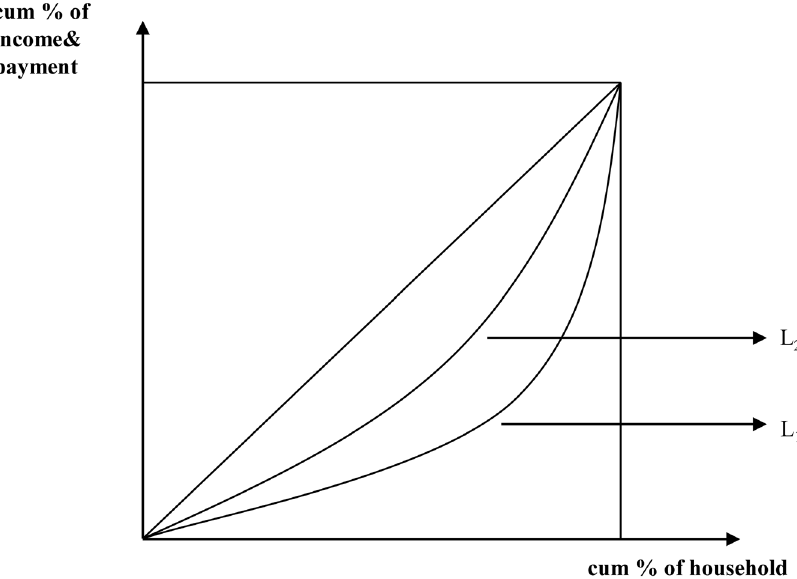
Figure 1. Conceptual cumulative concentration curve for healthcare payments and Lorenz curves. Conceptual cumulative concentration curve for healthcare payments and per capita household expenditure are shown. The concentration curve plots the cumulative percentage of healthcare payments (y-axis) against the cumulative percentage of the population (x-axis). Population is ranked according to ATP, from poorest to richest. The value of the concentration index is measured as twice the area between the concentration curve, L 1 , and the line of equality, L e (45 u line running from the bottom-left corner to the top-right). The Lorenz curve (L 2 ) represents the relationship between the cumulative percentage of per capita household expenditures and the cumulative percentage of the population, which is indicated by the Gini coefficient.